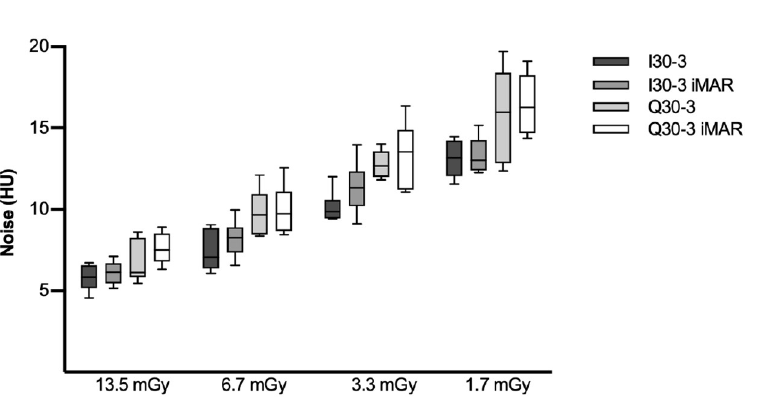
Fig 4. Boxplot of noise in an axial slice without artifacts. Noise is inversely proportional to dose level. Noise was lower, though not significantly so, for SE in comparison to DE.